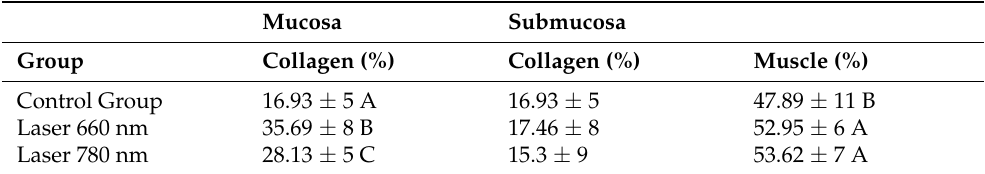
Figure 6. Representative histological sections of the collagen matrix in each group at 14 days (hematoxylin-eosin, × 400 original magnification). ( A ) Control group showing collagen fibers disposable in various directions and with high cellularity, suggesting poor remodeling. ( B ) The 660 nm group exhibiting a dense collagen matrix, without fiber patterns and fewer cellularity. ( C ) The 780 nm group showing a dense but more remodeled collagen matrix between the muscle fibers. Table 3. Mean percentage ± standard deviation of collagen fibers and muscle tissue in samples of oral mucositis after 14 days of ionizing radiation.